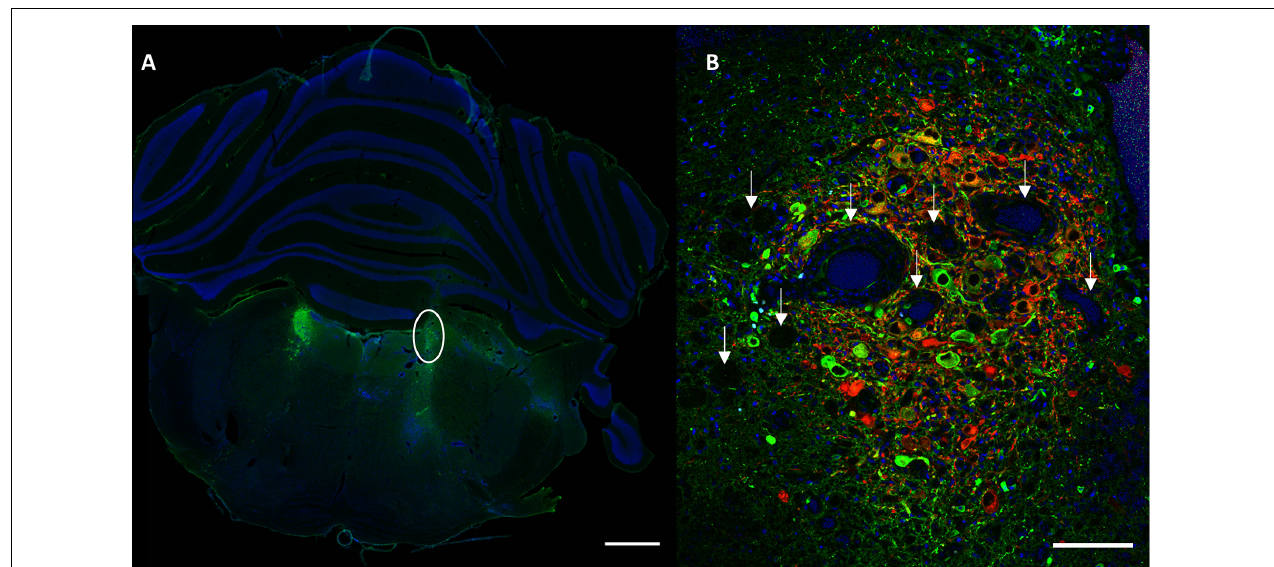
FIGURE 4 | Representative section visualizing signs of toxicity. (A) A clear difference in size of the transduced LC (right, encircled) compared to contralateral in animal injected with MediumV_10E9 condition. Only cell nuclei (DAPI, blue) and DBH + neurons (primary antibody anti-DBH, AF 488, green) are visualized in this image. (B) A clear decrease in number of LC neurons, in combination with the presence of lesions and vacuoles (indicated by the white arrows). LC-NA neurons and projections are visualized using primary anti-DBH antibody (green, AF 488 nm) and expression of hM3Dq DREADD is visualized using anti-RFP (red, AF 594 nm), cell nuclei are stained with DAPI (blue). Scale bar left image 1,000 µ m and right image 100 µ